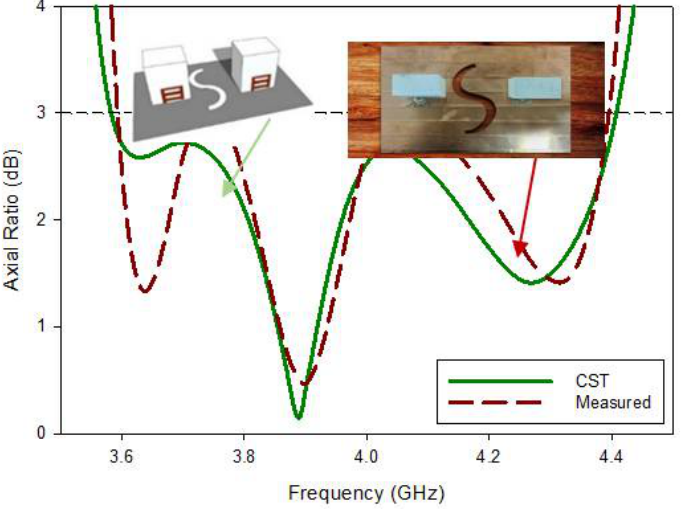
Figure 18. Comparison of the axial ratio of the fabricated and simulated MIMO antenna. After measuring the near-field parameters, we turned to the measurement of the far-field parameters, which started with measuring gain with the help of the substitution method, that is, having two standard horn antennas and the AUT (proposed antenna). The simulated gain of the proposed 1 × 2 CP MIMO RDRA antenna at a minimum axial ratio (3.88 GHz) was 6.01 dBic. Correspondingly, for the designed 1 × 2 CP wideband MIMO, the measured value of gain at the minimum of the resonance frequency of the axial was ~6.0 dBic. The theoretical and measured average gain readings are depicted in Figure 19. over the entire frequency band of interest. An average gain of ~ 6.00 dBic has been attained through the cp bandwidth in the simulated and fabricated results.